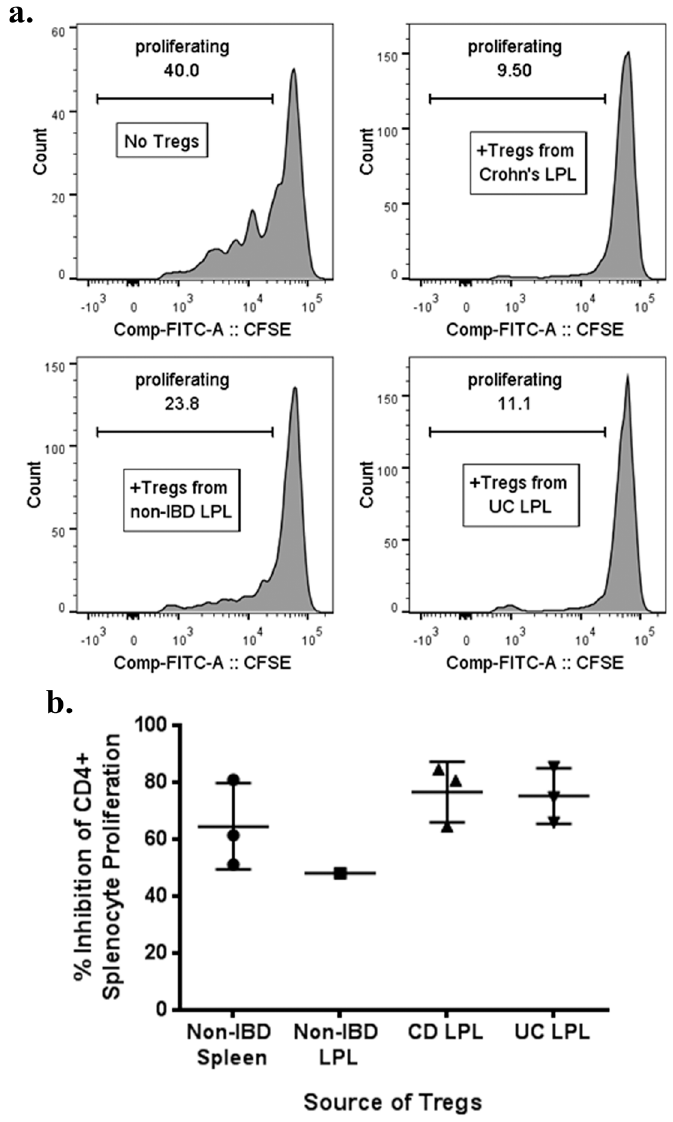
Fig 1. LPL Tregs from IBD patients are suppressive in vitro . CD25 + , CD127 - , CD4 + LPL Tregs homogenized from the surgically resected colons of patients with or without IBD were sorted and added at a 1:2 ratio to CFSE-labeled splenocytes from a single donor without IBD or other inflammatory or malignant conditions. As a control, autologous Tregs were similarly sorted from the splenocytes as well. Cells were cocultured in the presence of soluble anti-CD3 (OKT3) for 4 days and then CFSE dilution by CD4 + splenocytes was quantified on a flow cytometer. Representative histograms of CFSE dilution by these CD4 + splenocytes in the absence or presence of Tregs from different donors are shown (a). The percent that CD4 + splenocyte CFSE dilution was diminished by the presence of LPL Tregs from the indicated donors is shown (b). Each dot is a unique patient, except “ Non-IBD Spleen ” , for which Tregs from the same spleen donor were isolated de novo on each of three different days to serve as a control. CD = Crohn ’ s disease. UC = ulcerative colitis. LPL = lamina propria lymphocytes. of that described in Fig 1. CD4 + CD45RA - CD25 - effector T cells were sorted from LPL of four Crohn ’ s patients, four UC patients, and three patients without IBD. Because Th17 cells may be enriched in IBD LPL and may be particularly resistant to suppression by Tregs, these CD4 + effector T cells were further sorted into populations with or without the Th17 marker CD161.